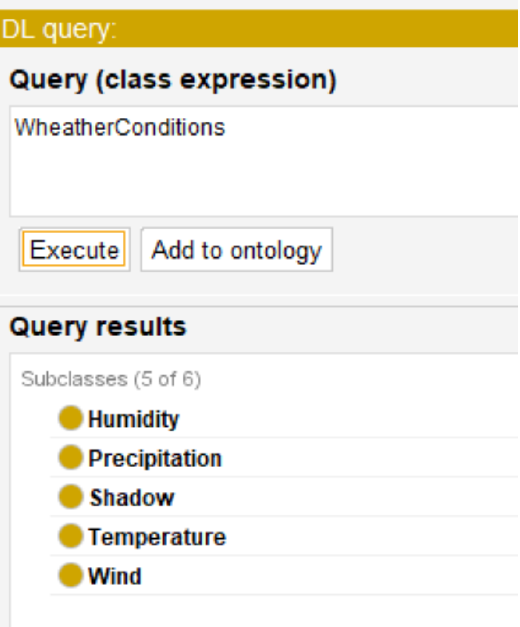
Figure 6. Weather conditions query using the Protégé editor and corresponding result, execution time was 40